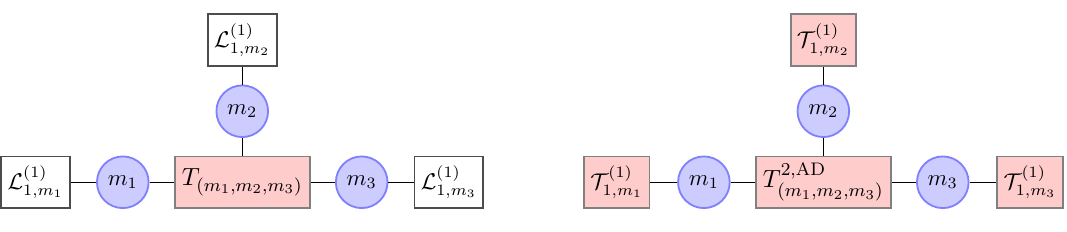
and T (1) corresponding to ( m 1 ; m 2 ; m 3 ) such that 1 ;n; 1 1 ;n; 1